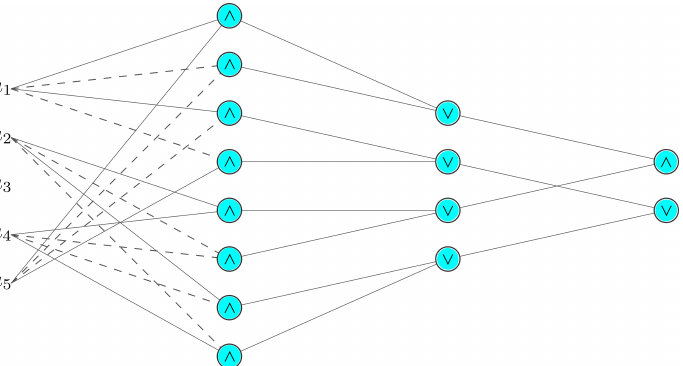
Figure 7. Five bit palindrome rule mapping onto a layered structure of L-neurons. The second layer of the network contains all the top-level expressions from (16), while the final layer implements (17) (passthrough connections are marked with solid lines, negations are marked with a dashed line and neutral connections are skipped for